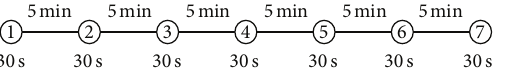
Figure 12: An urban rail line with 7 stations.